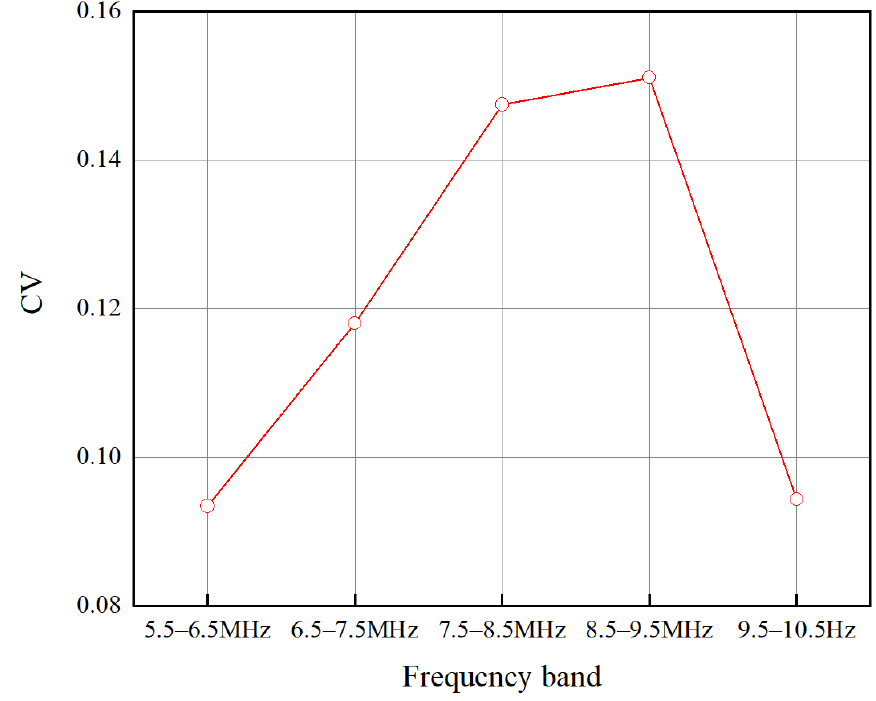
Figure 9. Value of CV in each frequency band.